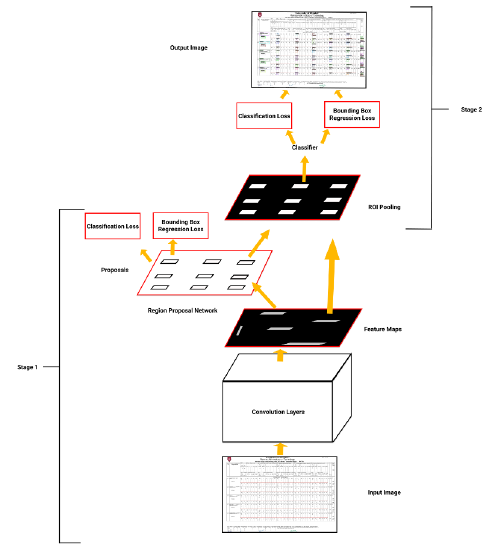
Figure 3. Working of Model